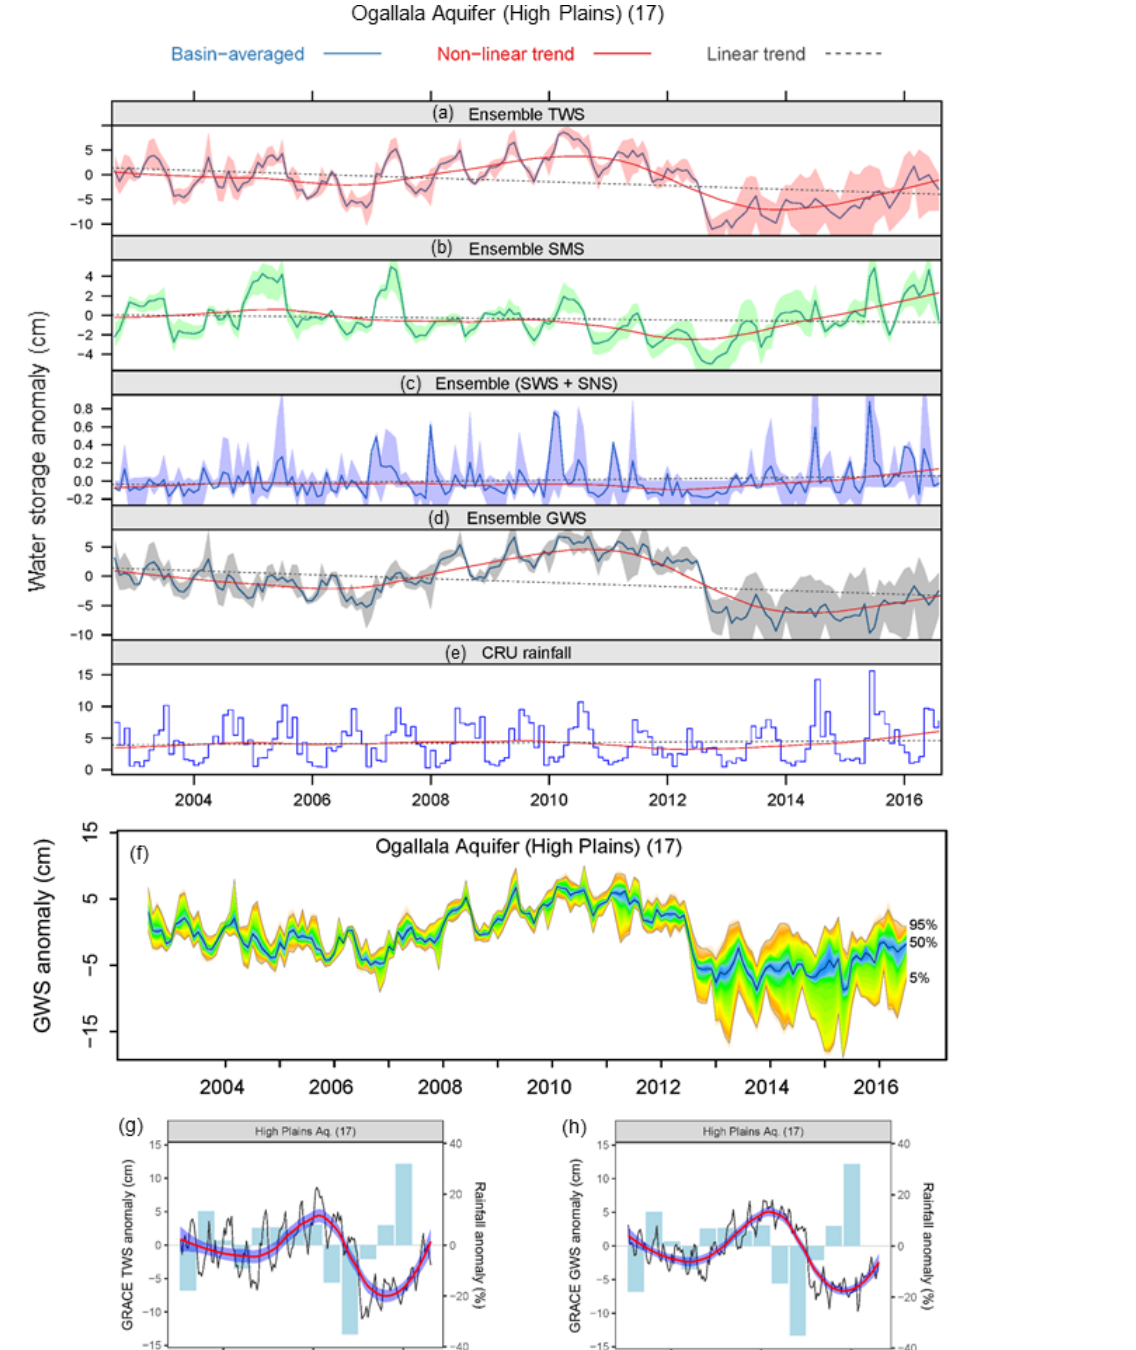
Figure 2. Time series data on terrestrial water storage anomaly ( (cid:49) TWS) from GRACE and individual water stores from GLDAS land surface models (LSMs): (a) ensemble monthly GRACE (cid:49) TWS from three solutions (CSR, Mascons, GRGS), (b–c) ensemble monthly (cid:49) SMS and (cid:49) SWS + (cid:49) SNS from four GLDAS LSMs (CLM, Noah, VIC, Mosaic), (d) computed monthly (cid:49) GWS and (e) monthly precipitation from August 2002 to July 2016, (f) range of uncertainty in GRACE-derived GWS from 20 realisations, (g) ensemble TWS and annual precipitation, and (h) ensemble GRACE-derived GWS and annual precipitation for the High Plains Aquifer System in the USA (WHYMAP aquifer no. 17). Values on the y axis in panels (a–e) show monthly water storage anomalies (cm), and panels (g, h) show monthly precipitation (cm). Time series data for the 36 large aquifer systems can be found in Figs.